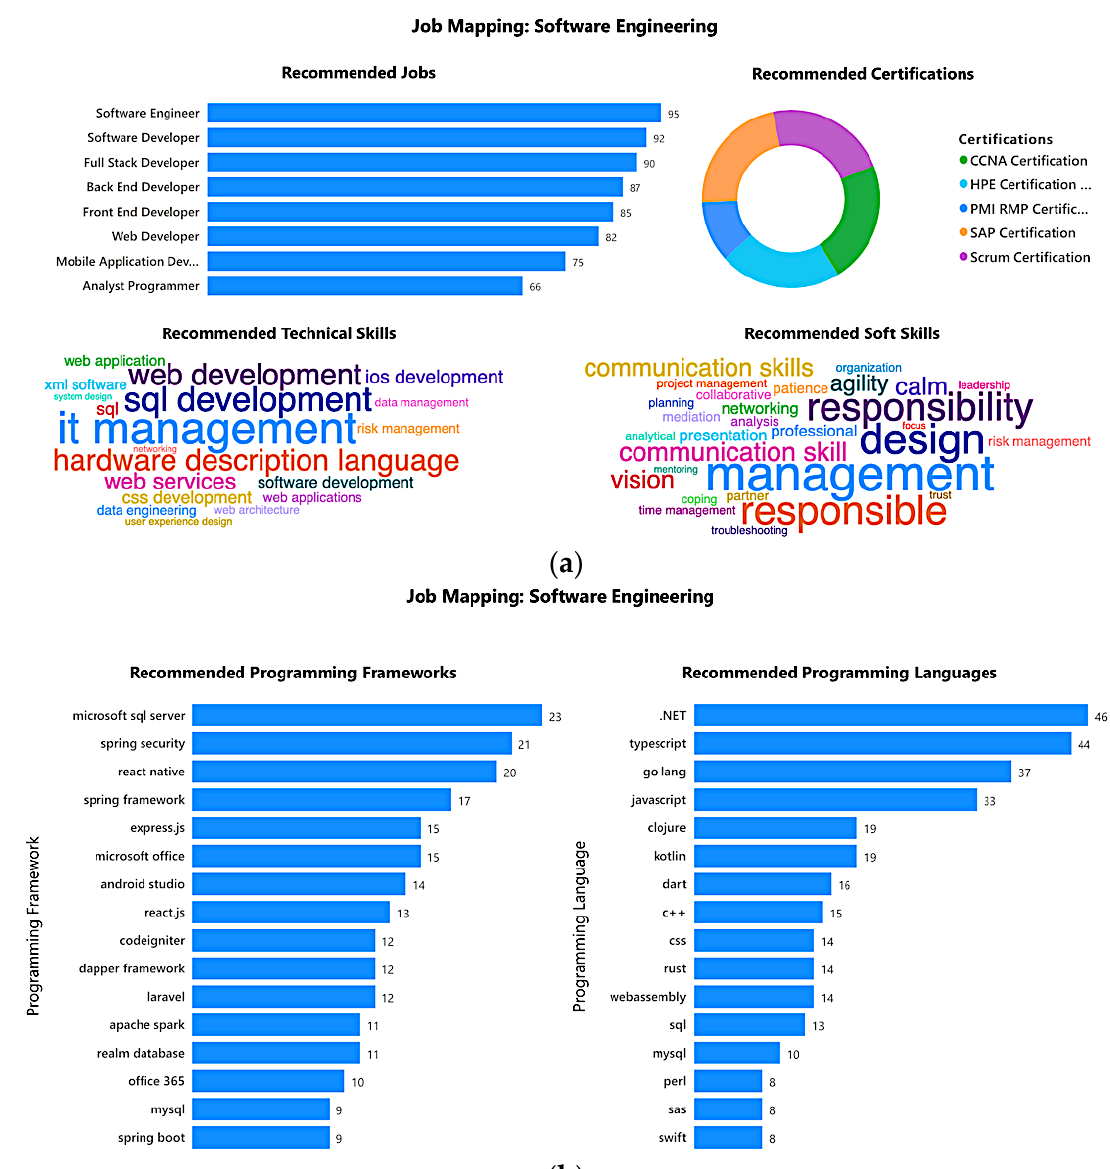
Figure 6. ( a ) Recommended jobs, certifications, and tech and soft skills for software engineers. ( b ) Recommended programming frameworks and languages for software engineering.